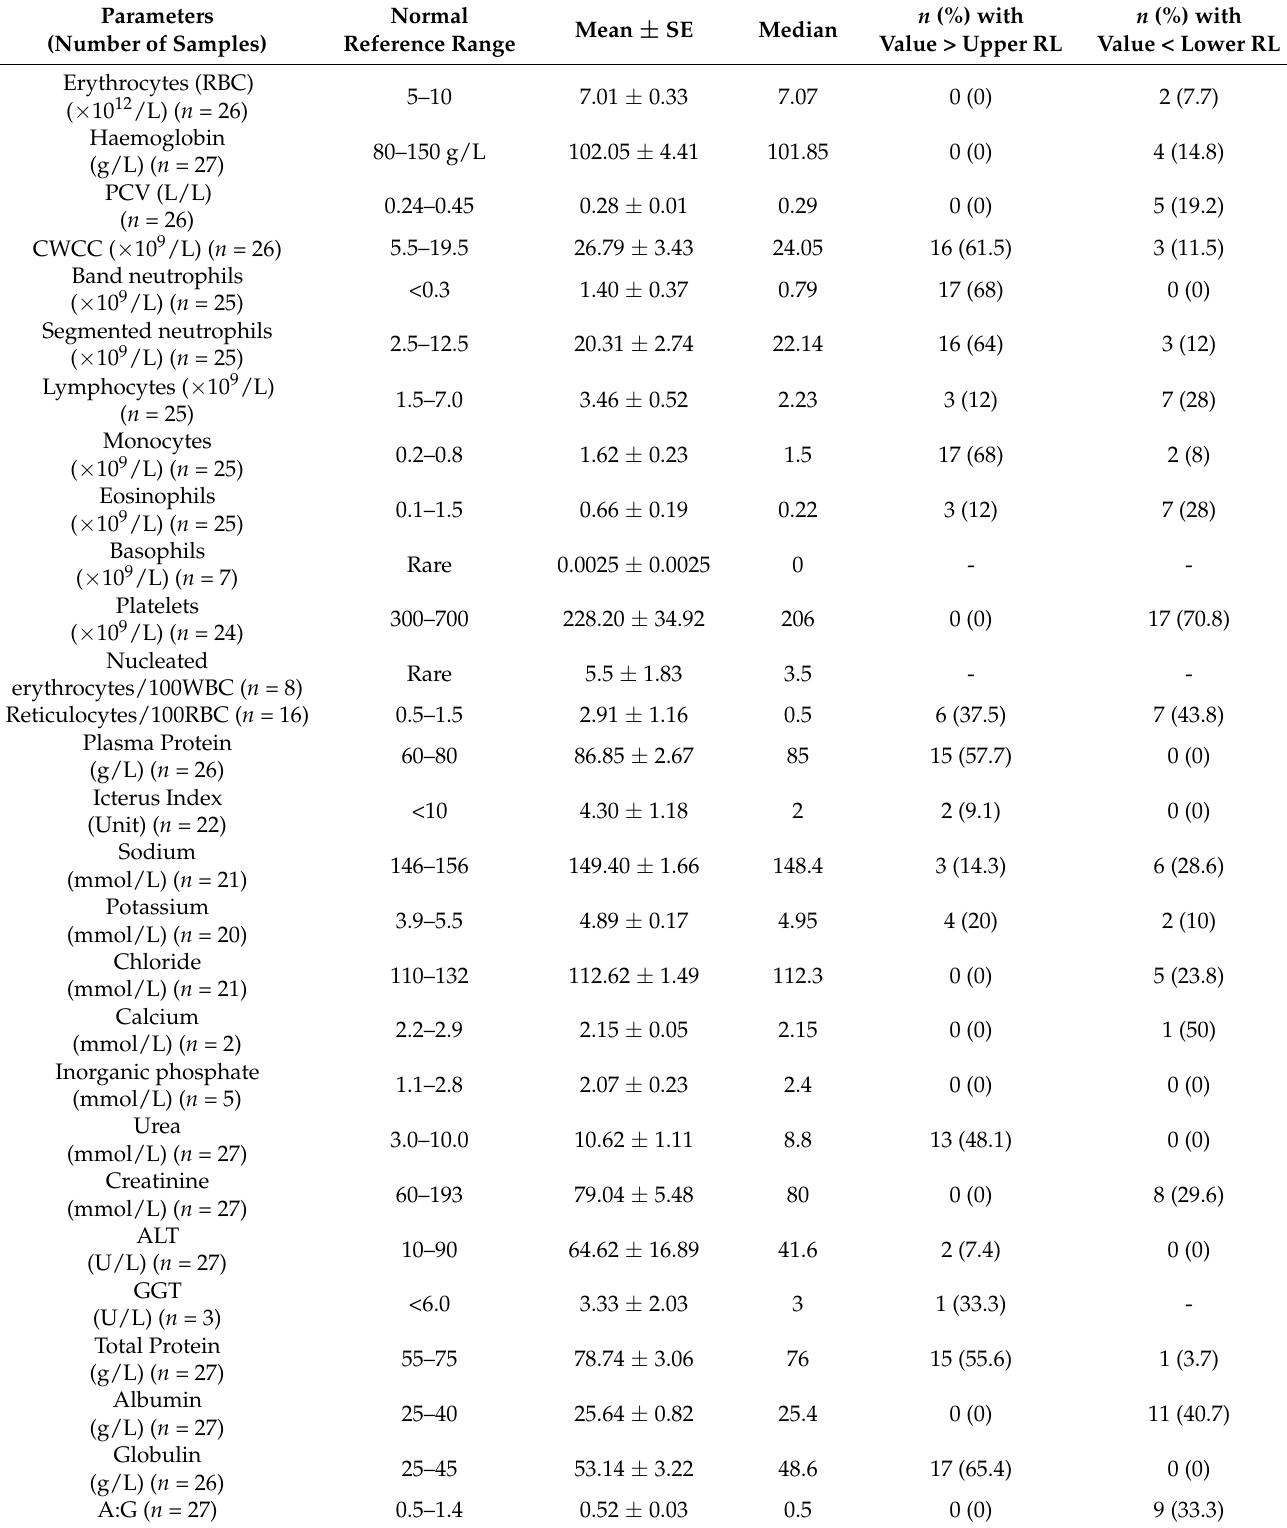
Table 5. Haematological and serum biochemistry parameters of 27 pyothorax